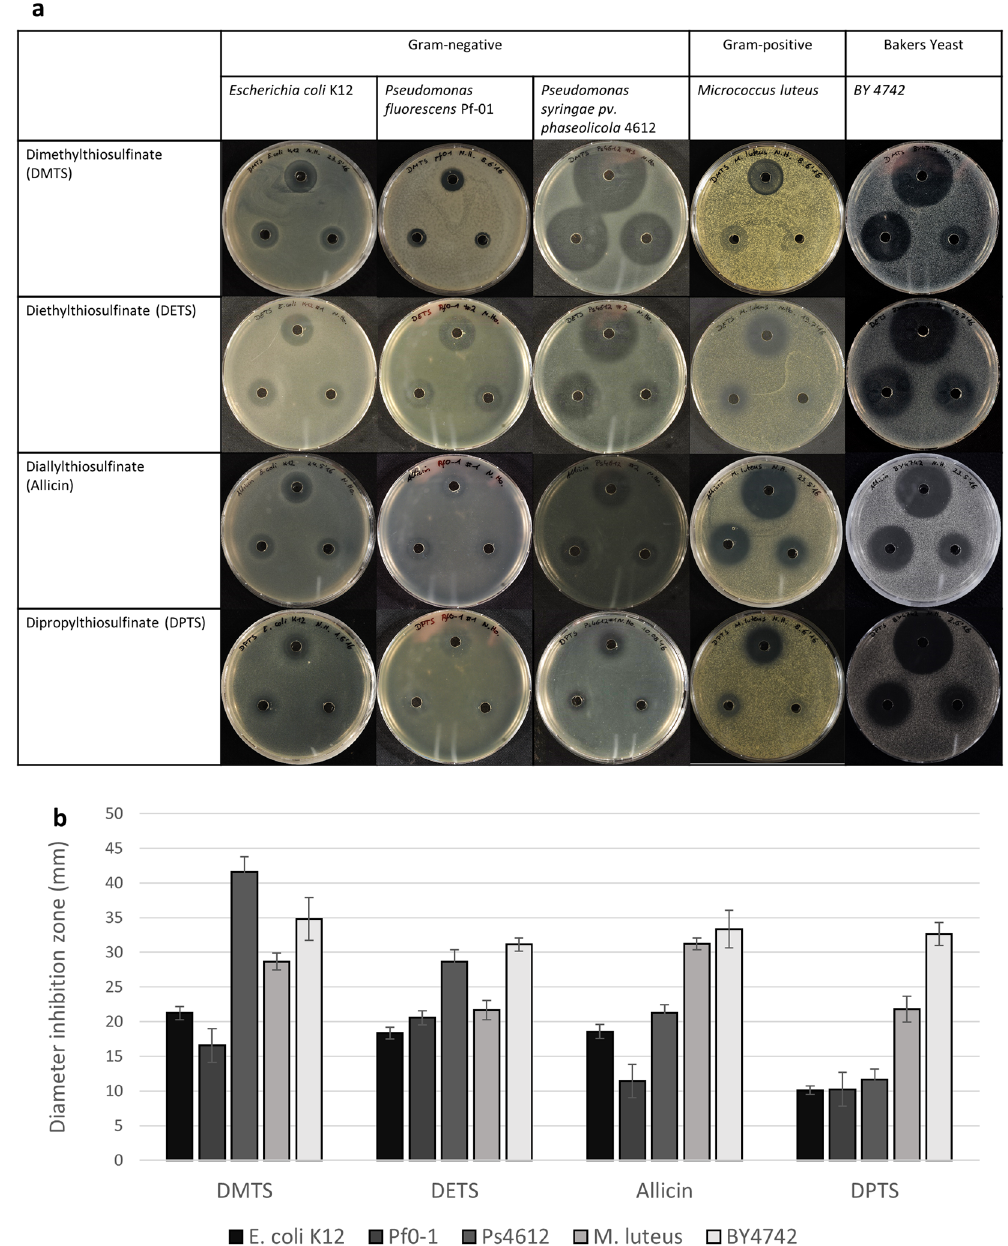
Figure 4. Plate inhibition zone assay showing the antimicrobial activity of different thiosulfinates against various bacteria and yeast. ( a ) Representative pictures for Gram-negative bacteria ( E. coli K12, Pseudomonas spp.), Gram- positive bacteria ( M. luteus ) and yeast BY4742 cells. Cells were incorporated in 50 °C warm agar and poured into a Petri-dish. The upper well contained 20 µ L of 8 mM solution, the hole at the left side of each Petri-dish contained 20 µ L of 4 mM solution and the hole at the right side of the Petri-dish contained 20 µ L of 2 mM solution of each compound tested. ( b ) The diameter of inhibition zone was measured for the hole containing 20 µ L of 8 mM solution of the test compound. Error bars show standard deviation about the mean, n =